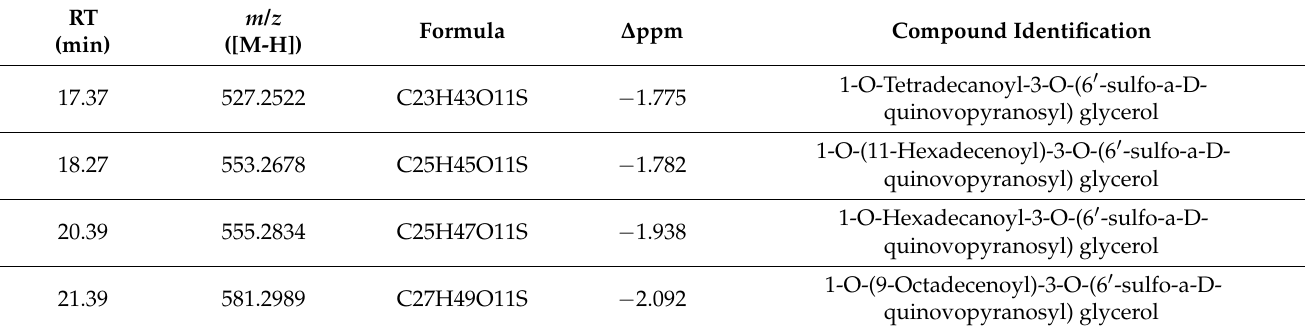
Table 1. Metabolite profiling of crude ethanol extract of S. horneri